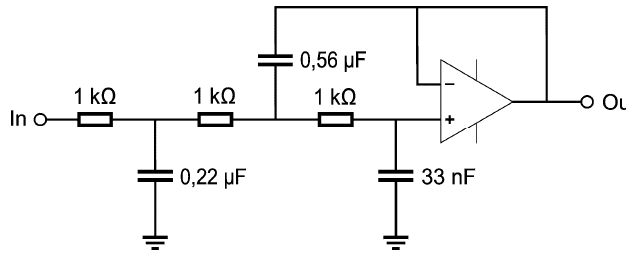
Figure 8. Third order Butterworth active low-pass filter.